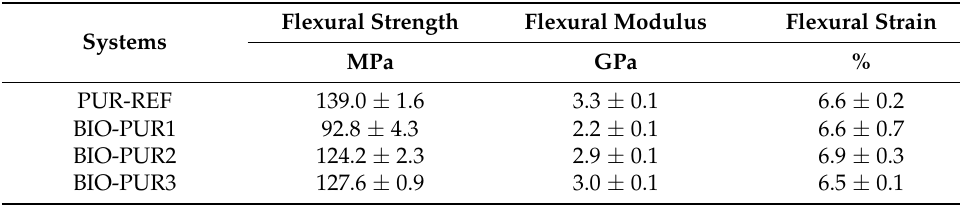
Table 3. Flexural properties of PUR systems.